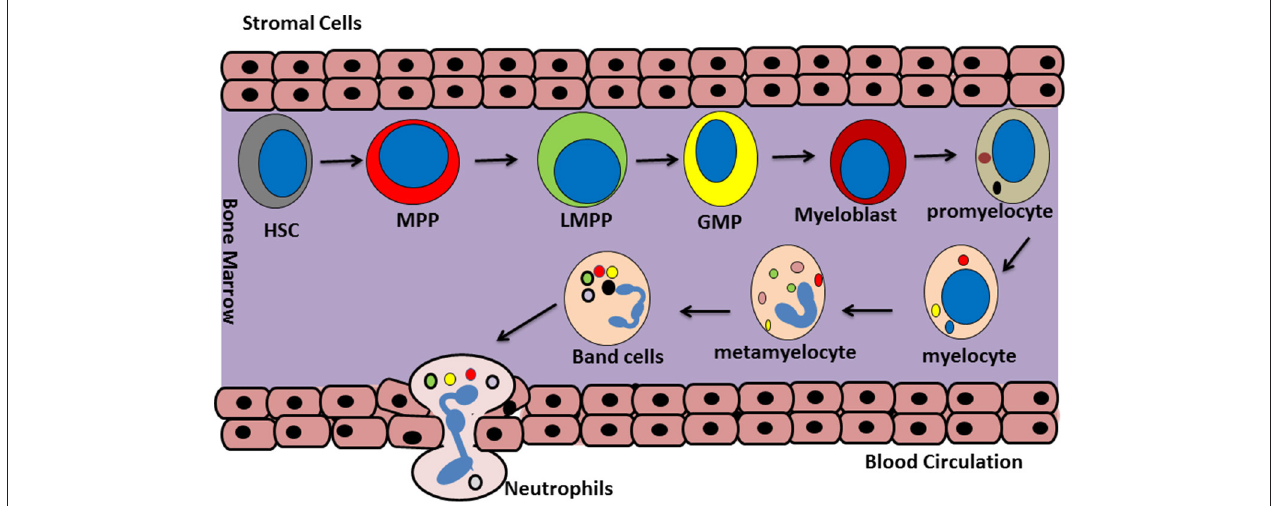
FIGURE 1 | Neutrophils generation. Granulopoiesis or neutrophil generation occur in the bone marrow. At the first step, a self-renewing hematopoietic stem cell (HSC) differentiate to a multipotent progenitor (MPP) cell. Then MPP differentiate to lymphoid-primed multipotent progenitors (LPMP), which give rise into granulocyte-monocyte progenitors (GMP). After that, GMP cells turn in to myeloblast and posses through a maturation process including promyelocyte, myelocyte, metamyelocyte, band cell, and finally will commit to generate the mature neutrophils.